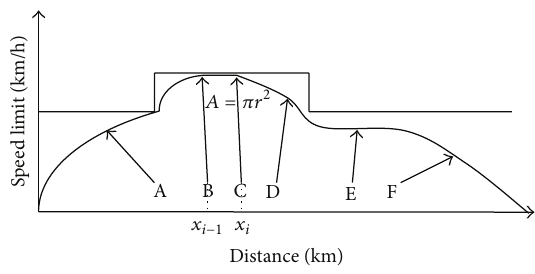
Figure 2: Diagram of different running status during one journey.